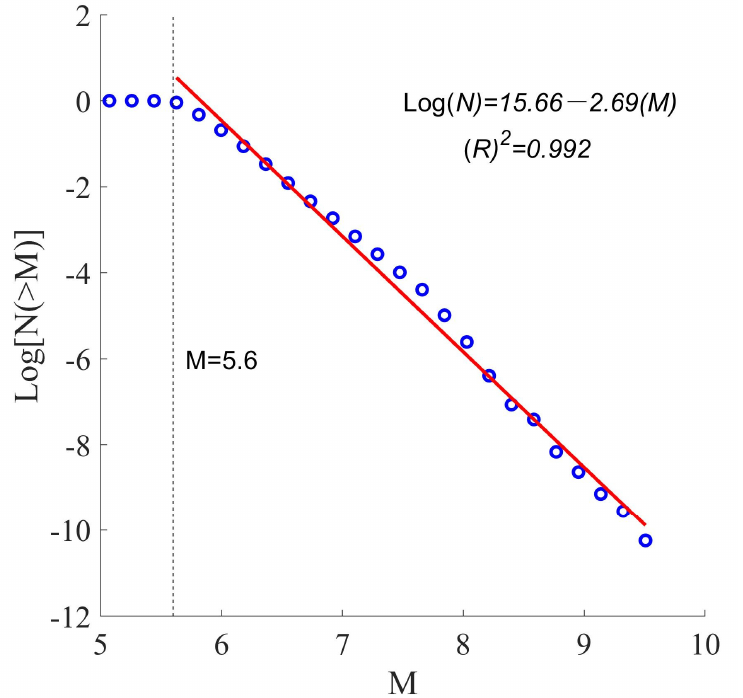
Figure 1. Accumulative frequency-size distribution of the earthquake dataset acquired from the ISC with a time range from 1904 to 2014.